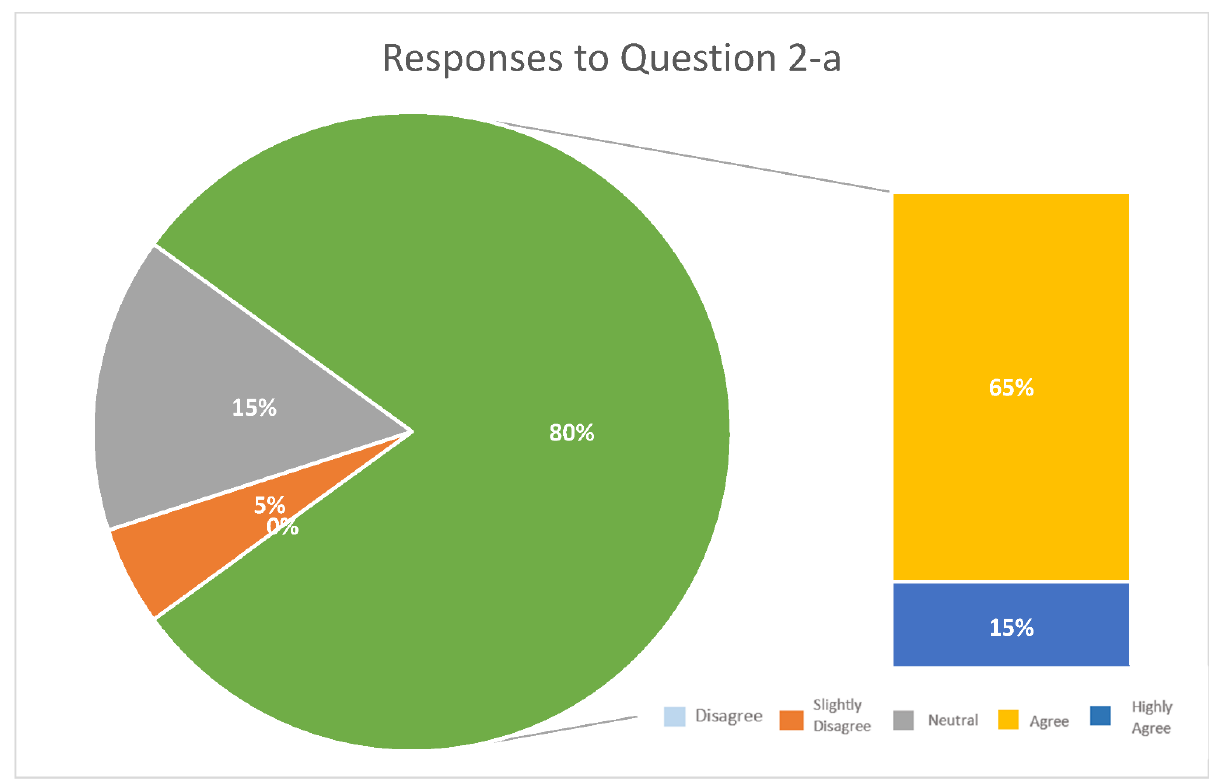
Figure 9. Responses to Question 2-a.